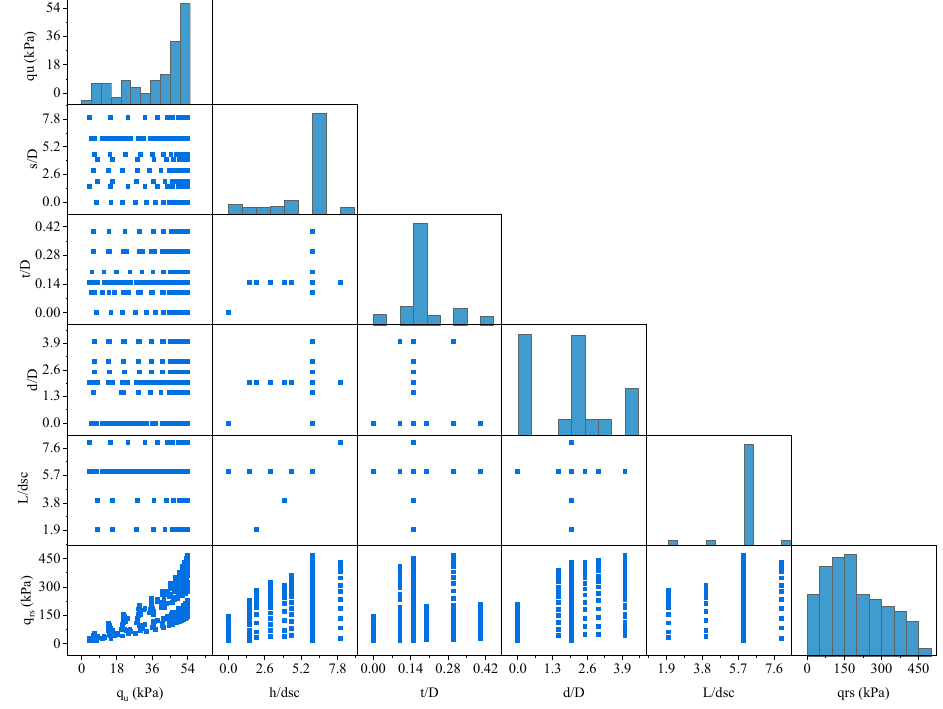
Figure 2. Relative frequency distribution of input and output variables.